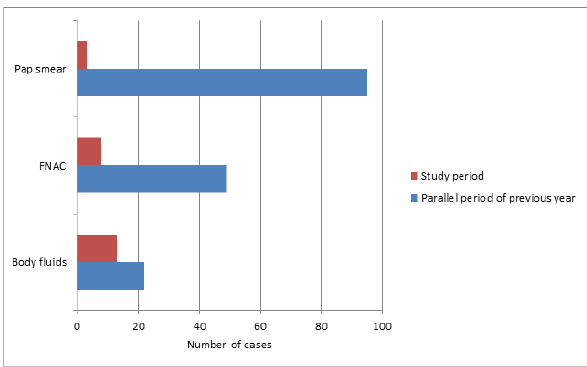
Figure 1: Comparison of the volume of histopathological specimens